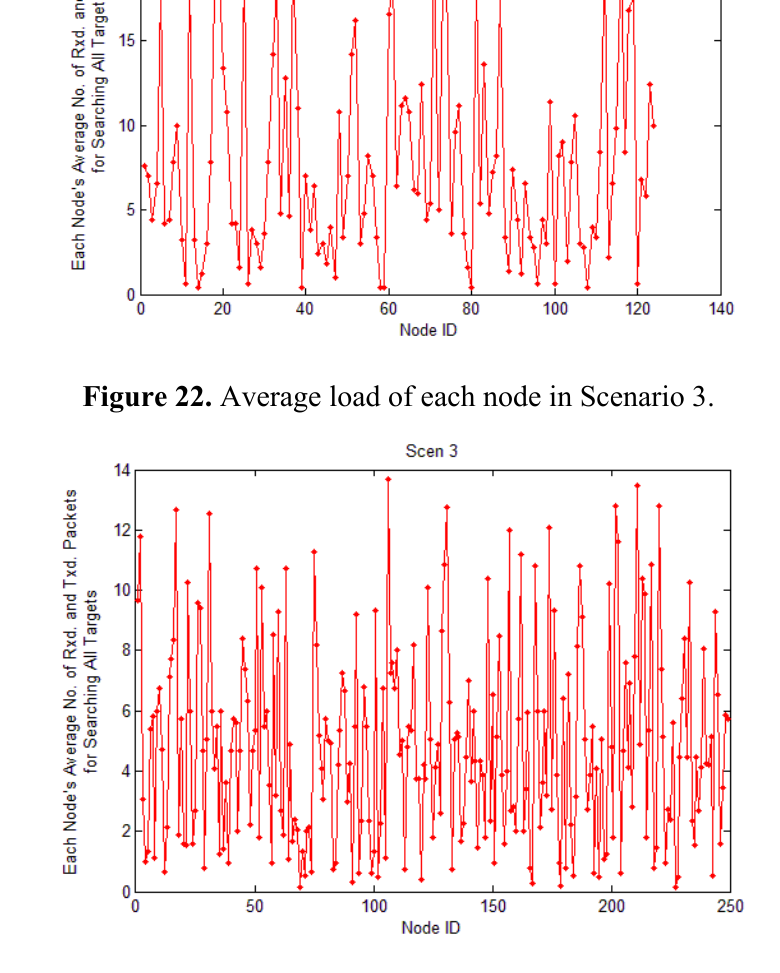
Figure 23. Fraction of nodes that have processed the query packet against the target node’s